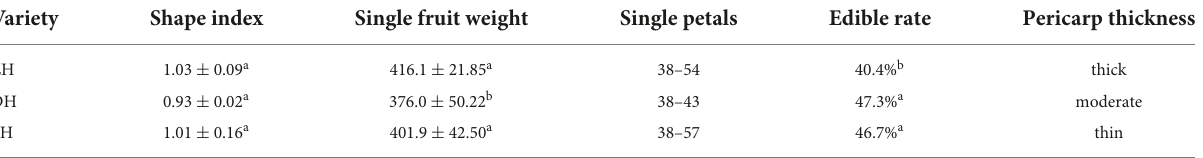
TABLE 1 Physical quality of Kadsura coccinea.